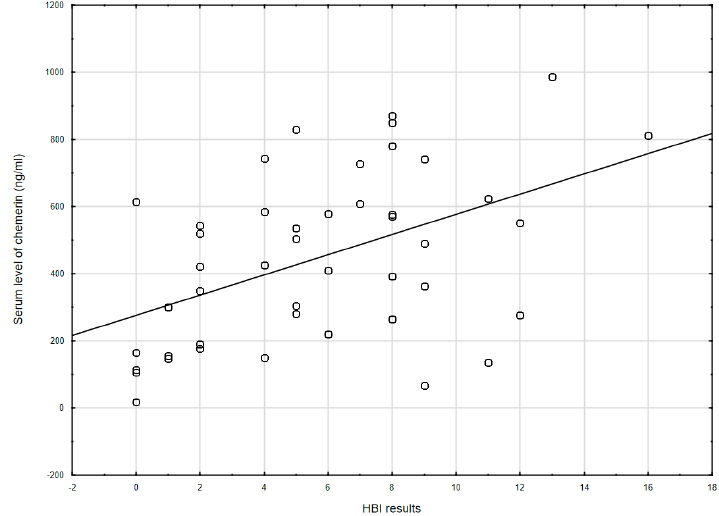
Figure 1. The correlation between chemerin concentration and the Harvey–Bradshaw index results (r = 0.478, p = 0.001) in CD patients. HBI: Harvey–Bradshaw index.